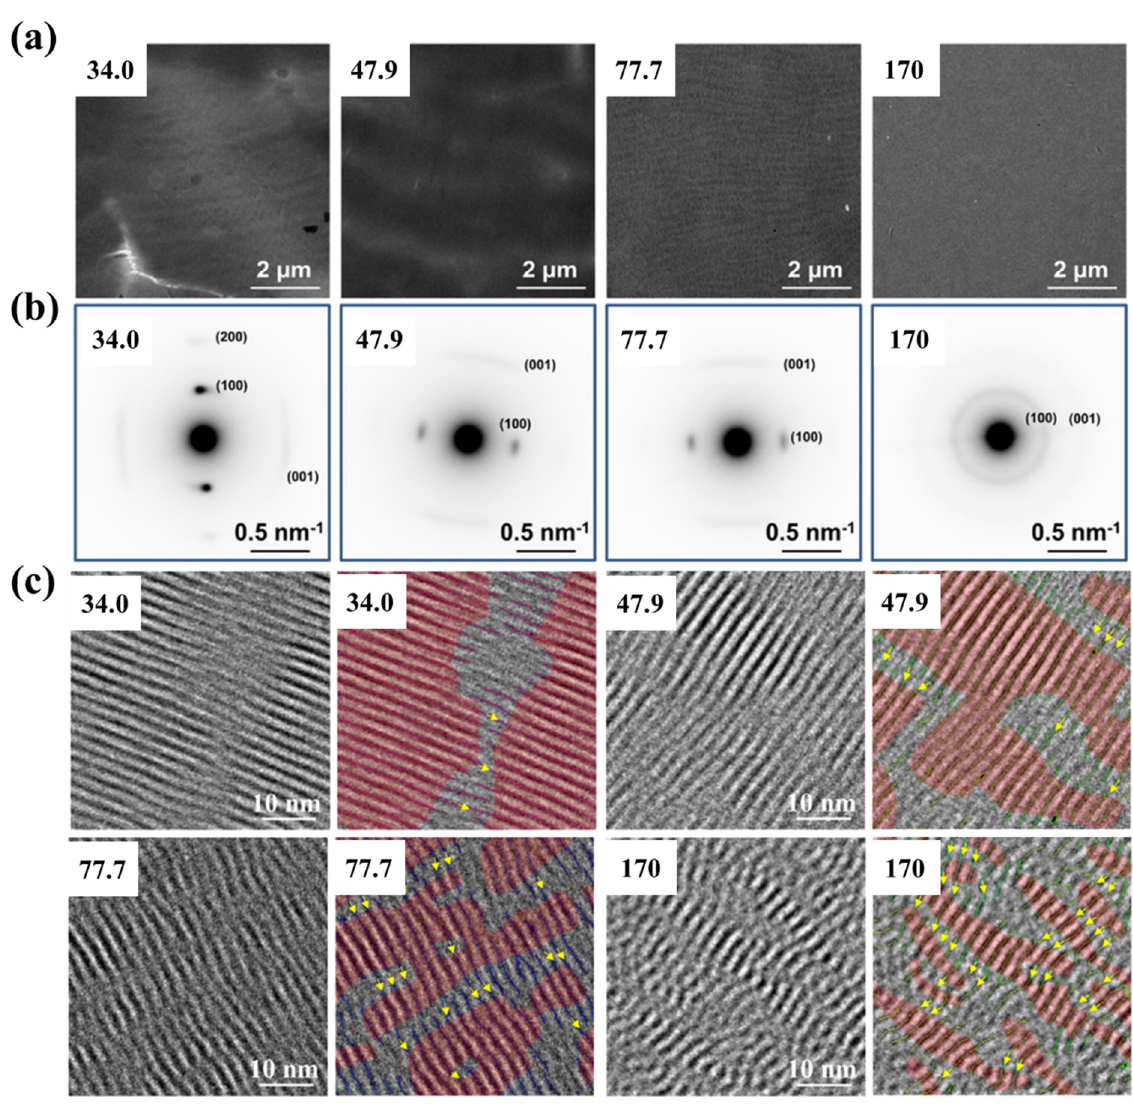
Figure 10. TEM images ( top ), SAED patterns ( middle ) and HRTEM images ( bottom ) of drop-casted PNDI films with various MWs (kDa), which were adapted from reference [141] with permission from Copyright 2021 American Chemical Society.